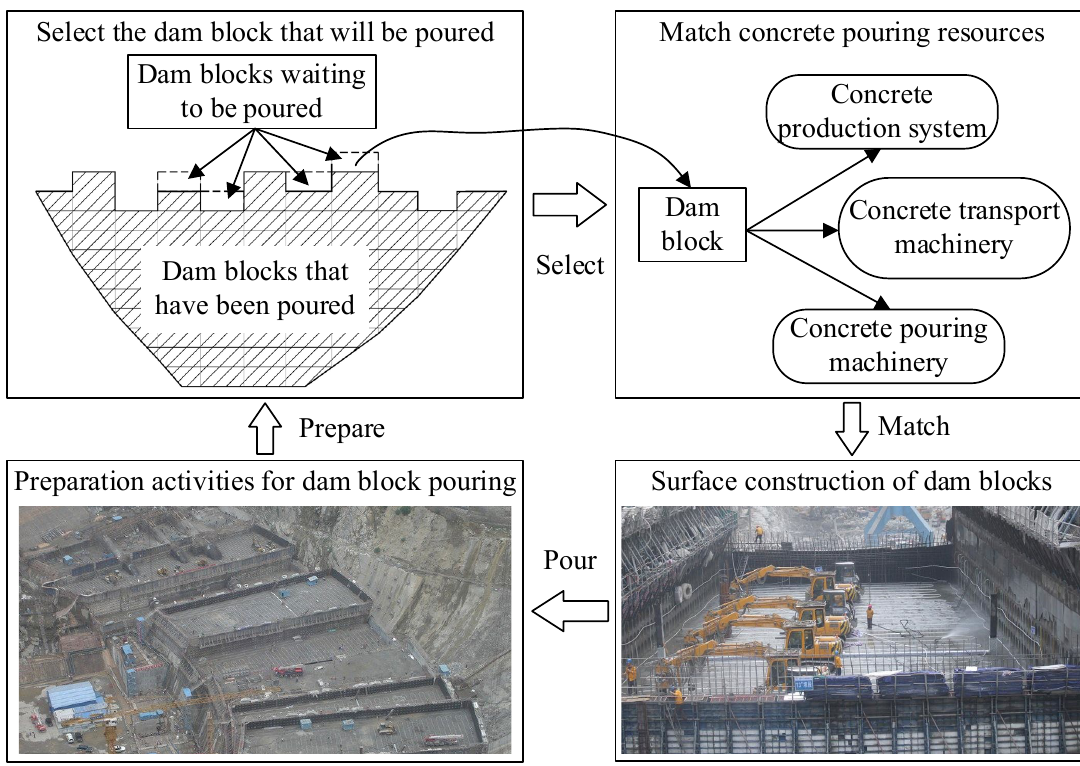
Figure 1. Description of construction process for concrete dams.